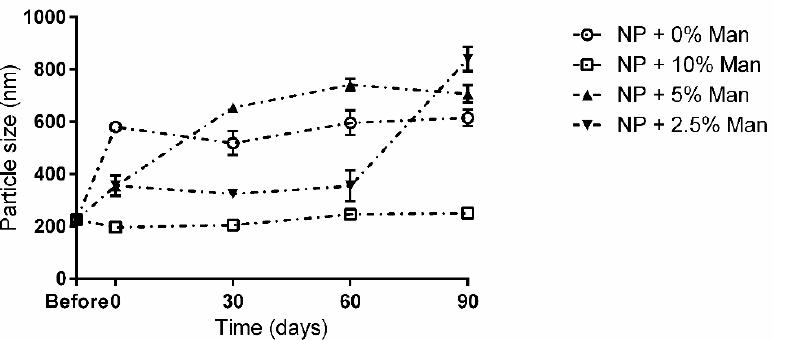
Figure 3. Long term storage impact on NP size in the presence and absence of mannitol. ⊚ —NPs without cryoprotectant; (cid:31) —NPs with 10% ( w / v ) mannitol; ▲ —NPs with 5% ( w / v ) mannitol; ▼ —NPs with 2.5% ( w / v ) mannitol.